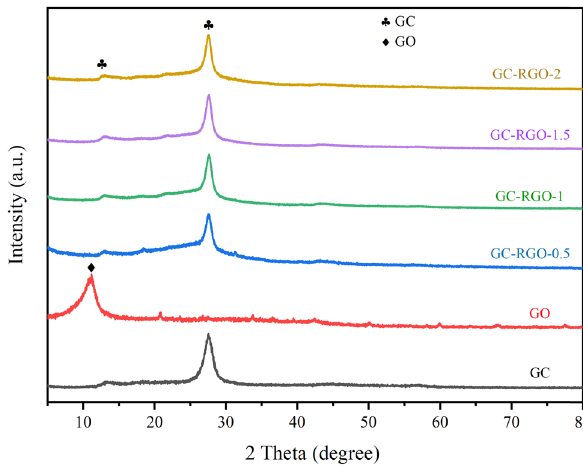
Figure 2: The XRD patterns